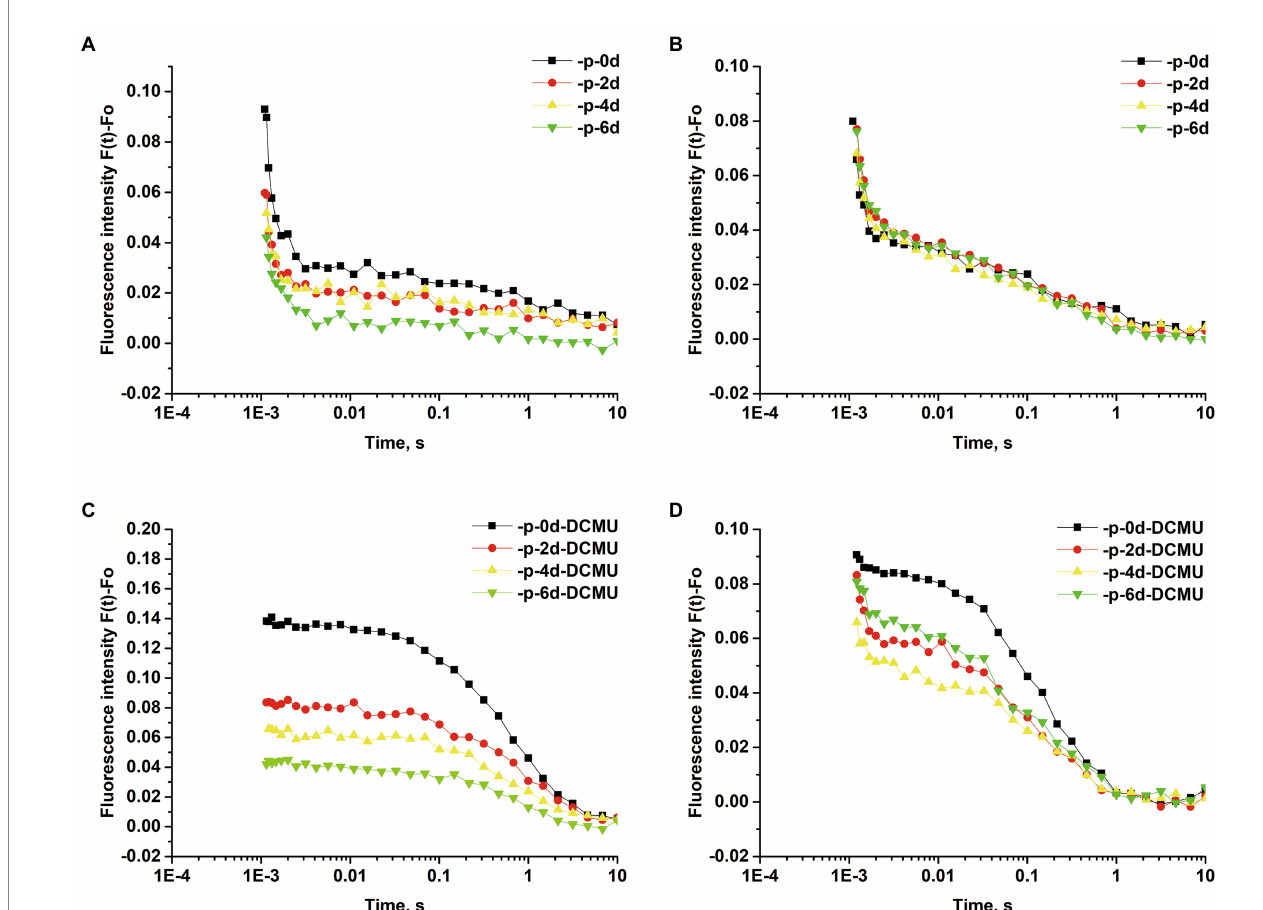
FIGURE 6 Normalized Q A − reoxidation kinetic curves of S . costatum and P . globosa in +P and − P groups for various periods of time. Fluorescence decay in the absence of 3-(3,4-dichlorophenyl)-1,1-dimethylurea (DCMU) of S . costatum (A) and P . globosa (B) . Fluorescence decay in the presence of 20 μ M DCMU of S . costatum (C) and P . globosa (D) . Each value represents the mean of the results from triplicates (Error bars